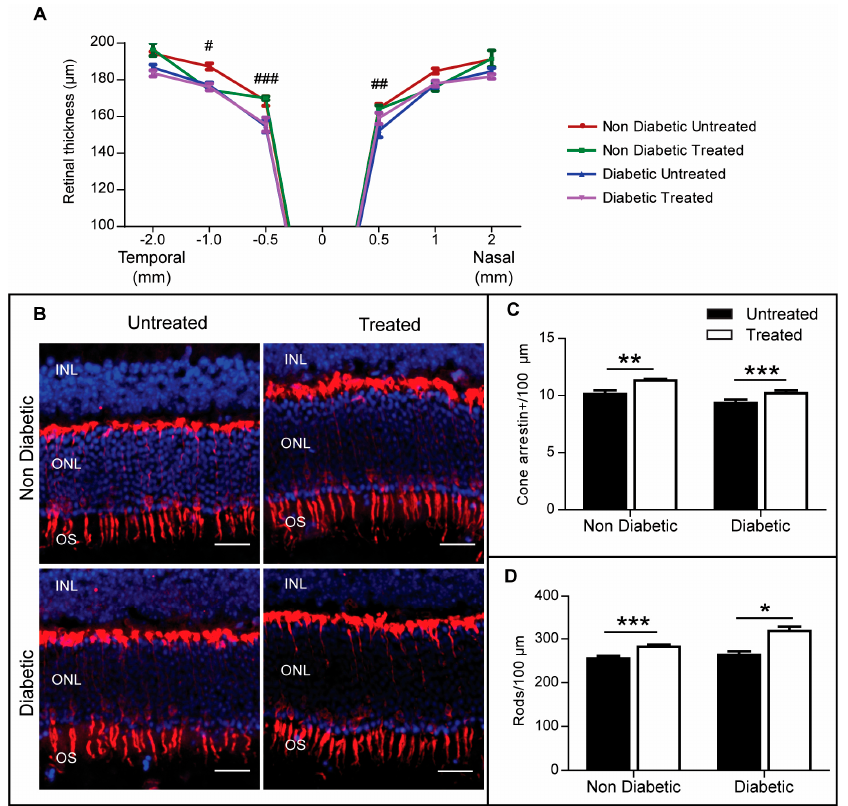
Figure 4. 3TC protects photoreceptors from age-related degeneration. ( A ) Average retinal thickness across the temporal-nasal axis acquired via quantitative spectral domain optical coherence tomography (SD-OCT), n = 6 eyes per experimental condition. Two-way ANOVA with Tukey’s multiple comparisons test. # p < 0.05, ## p < 0.01, and ### p < 0.001 between non-diabetic untreated and diabetic untreated animals. ( B ) Cryosections from each experimental condition were stained for cone arrestin (red) and counterstained with DAPI (blue). The average number of cones (cone arrestin-positive cells) or rods (DAPI-positive cells in the ONL minus cones) were quantified and normalised to 100 μ m of retina length. INL: inner nuclear layer; ONL: outer nuclear layer; OS: outer segment. Scale bar: 25 μ m. ( C ) Average number of rods per 100 μ m. ( D ) Average number of cones. Data are shown as mean ± SEM. n > 40 images from 3–5 different animals per experimental condition.